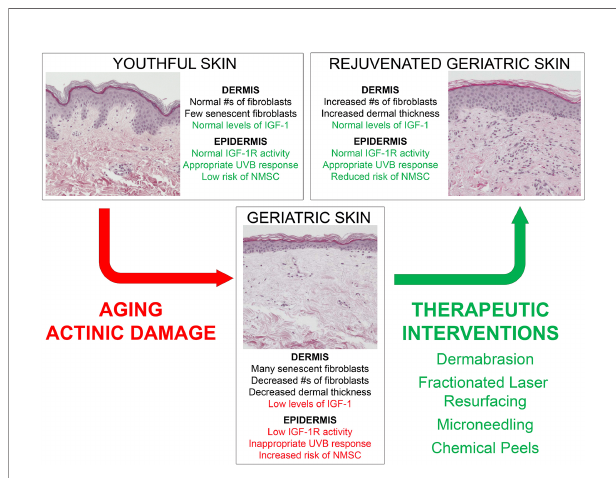
FIGURE 2 | Model demonstrating young versus aged skin and the impact of wounding therapies on the response of geriatric skin to